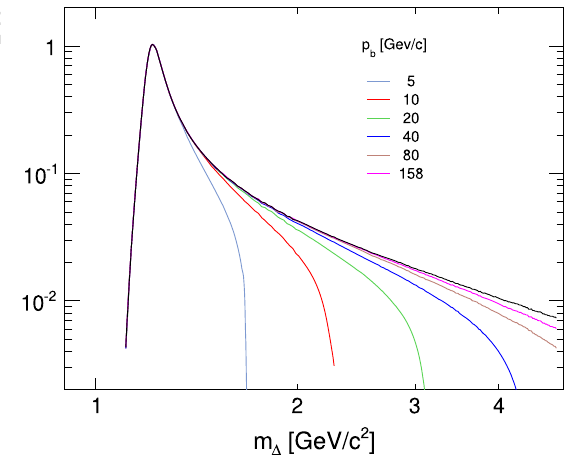
Fig. 161 Relativistic Breit–Wigner mass distributions for final state Delta baryons in p+p interactions at beam momenta between 5 and 158 GeV/c